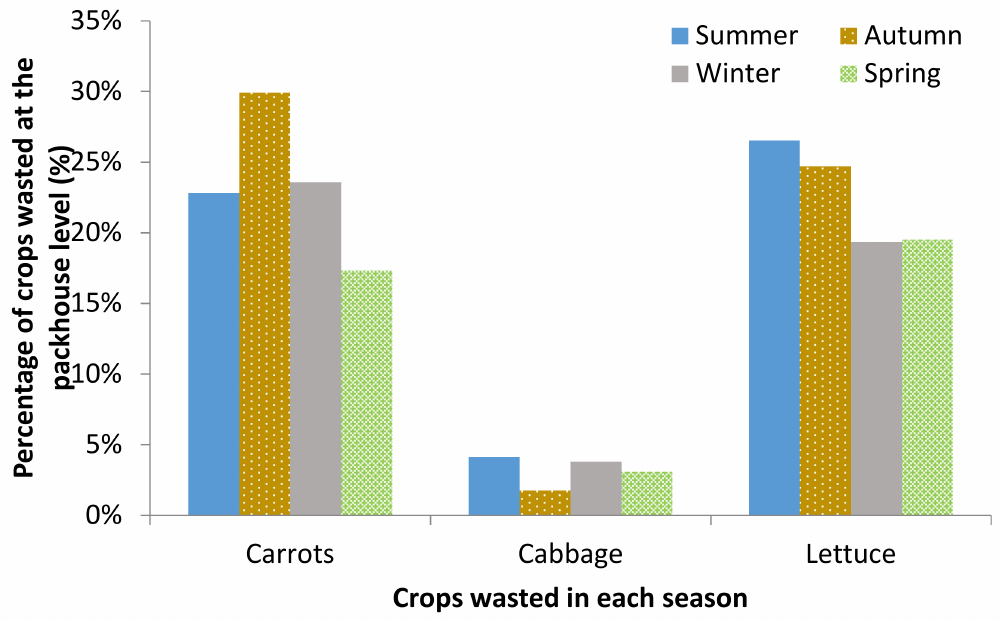
Figure 2. Wastage of carrots, cabbage and lettuce in each season in a packhouse on the Steenkoppies Aquifer. Carrot values are assumed to represent beetroot values, and cabbage values are assumed to represent broccoli